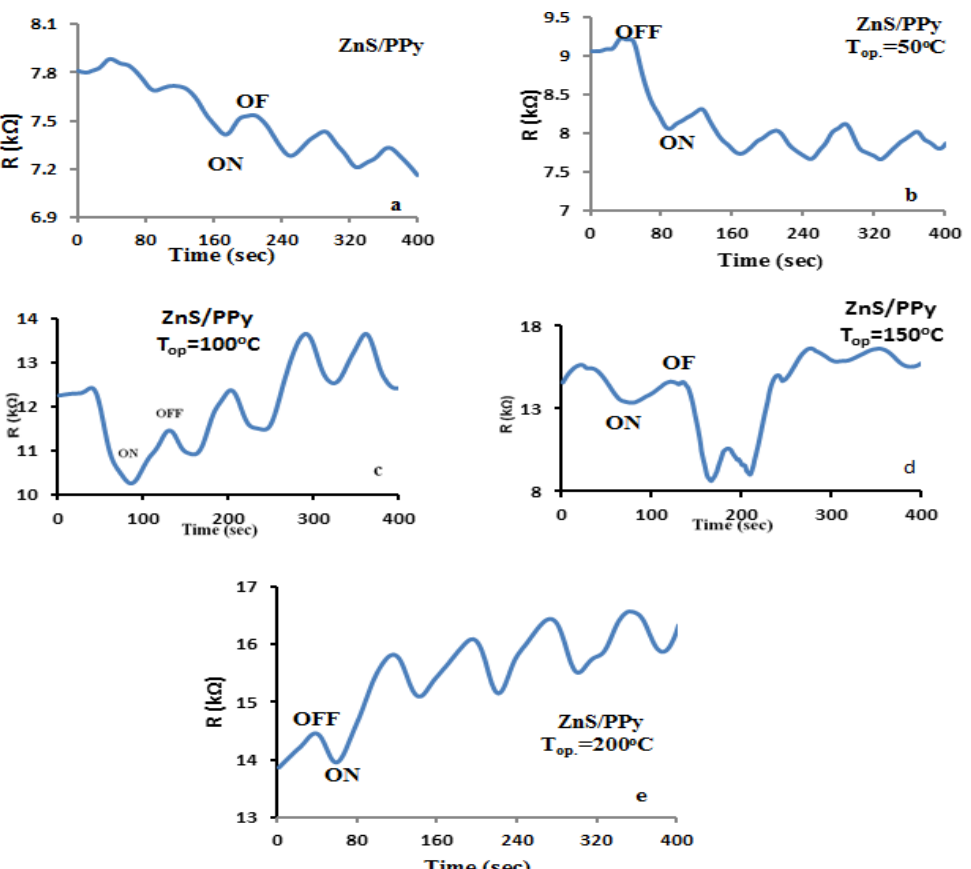
Fig.6: The variation of resistance with time for ZnS-PPy at different operating temperatures against NO 2